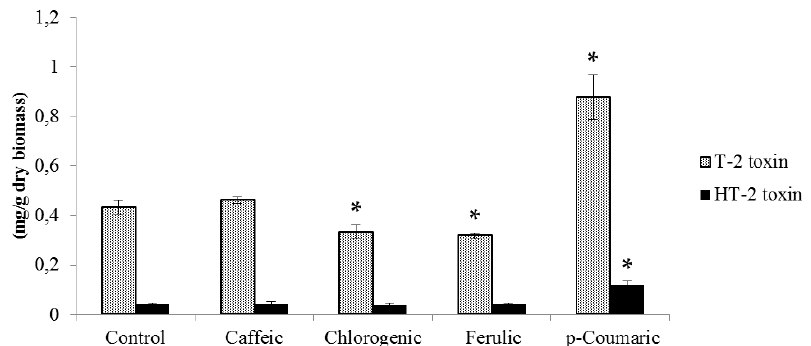
Figure 1. T ‐ 2 and HT ‐ 2 toxin production by F. langsethiae at 0.5 mM of each phenolic acid incubated at 25 °C for 14 days. Values expressed as mean values ± SD of three biological replications. The sign * indicates significant difference with respect to control according to t ‐ test ( p < 0.05).